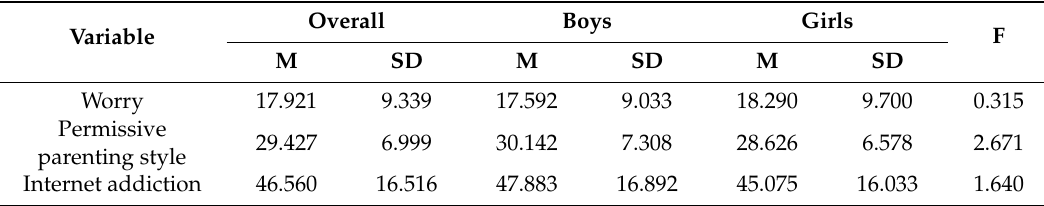
Table 1. Gender di ff erences in worry, the permissive parenting style, and Internet addiction. M: mean; SD: standard